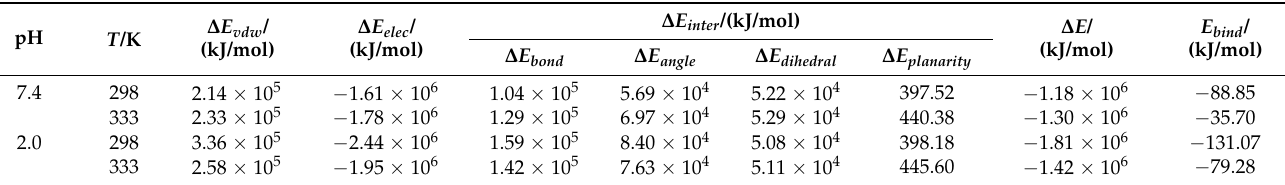
Figure 6. The effects of temperature on the number of hydrogen bonds of β -casein-curcumin complex during 60 ns MD simulation at pH 7.4 ( A ) and pH 2.0 ( B ). Table 3. Various energy items in the